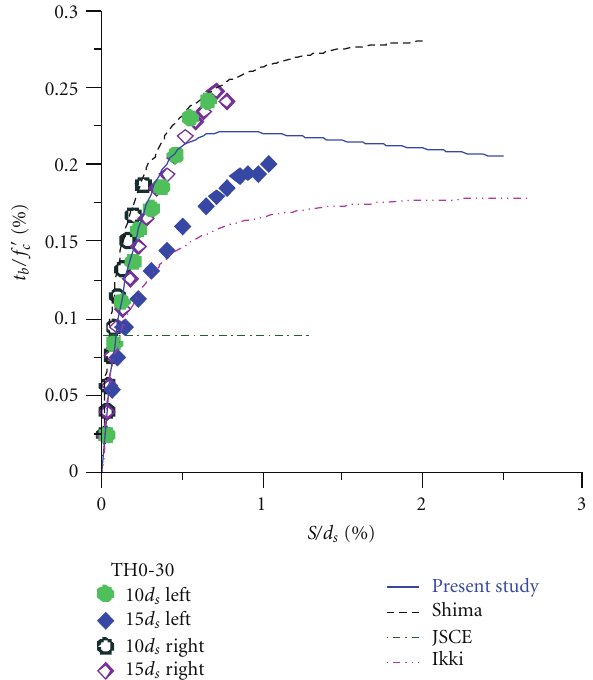
Figure 9: Bond stress-slip relationship of TH0-30 specimen.